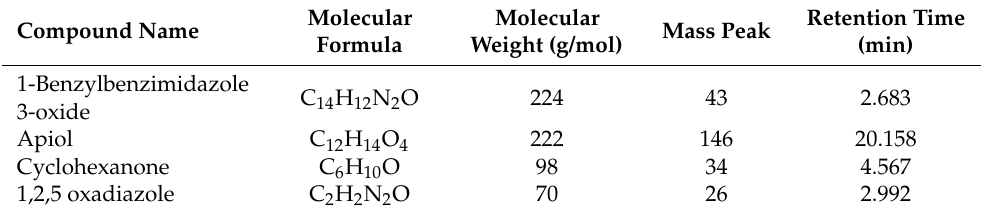
Table 2. GC-MS analysis of P.aAF and identification of